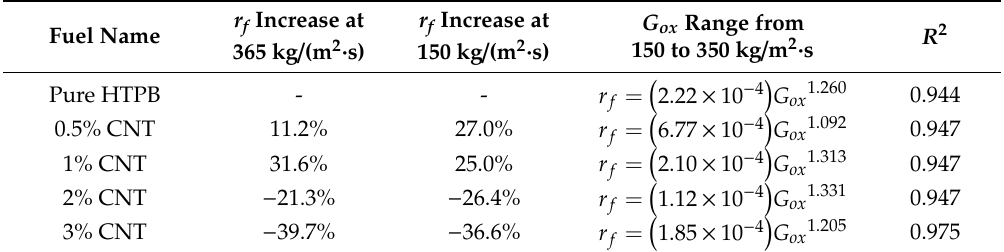
Table 11. r f increase and fitting results of r f / G ox curves for hydroxyl-terminated polybutadiene /